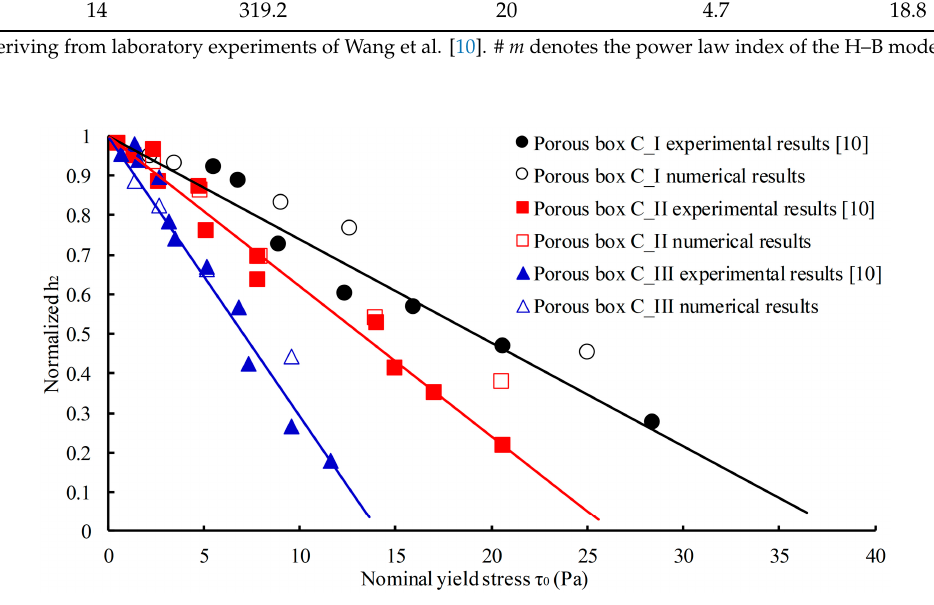
Figure 4. Normalized h 2 of SCM distribution versus yield stress of SCM.